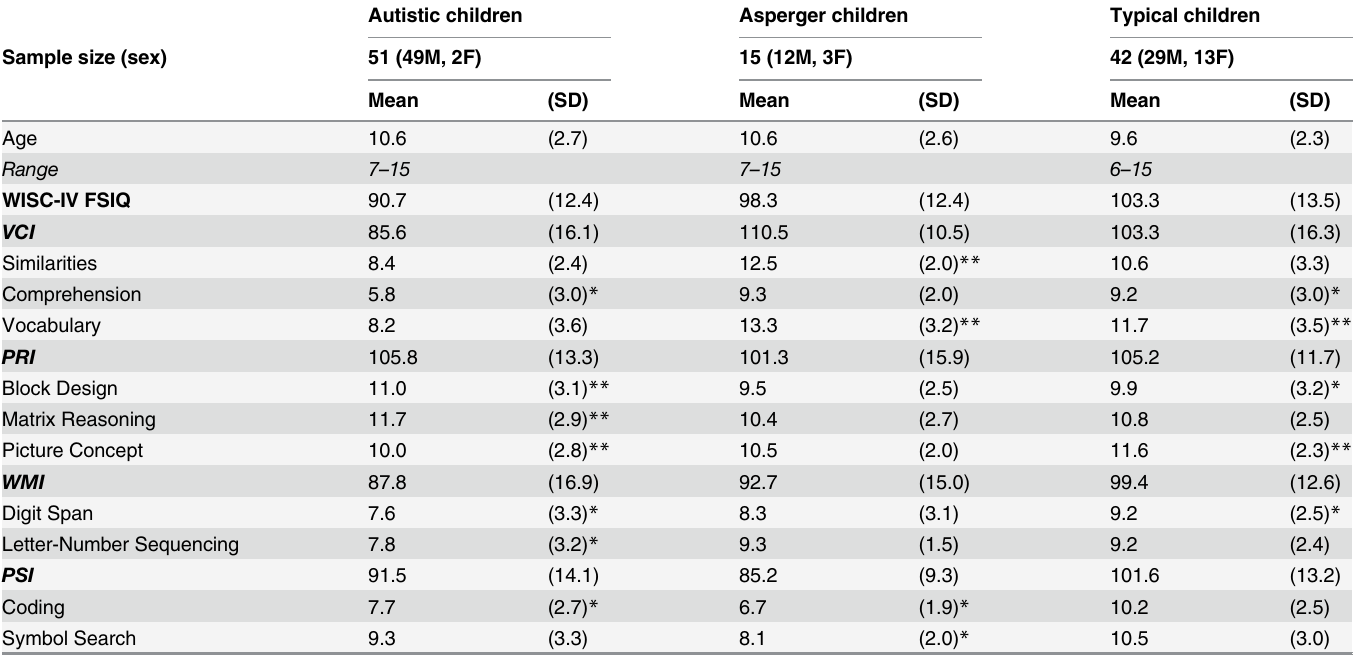
Table 2. WISC-IV cognitive profile.